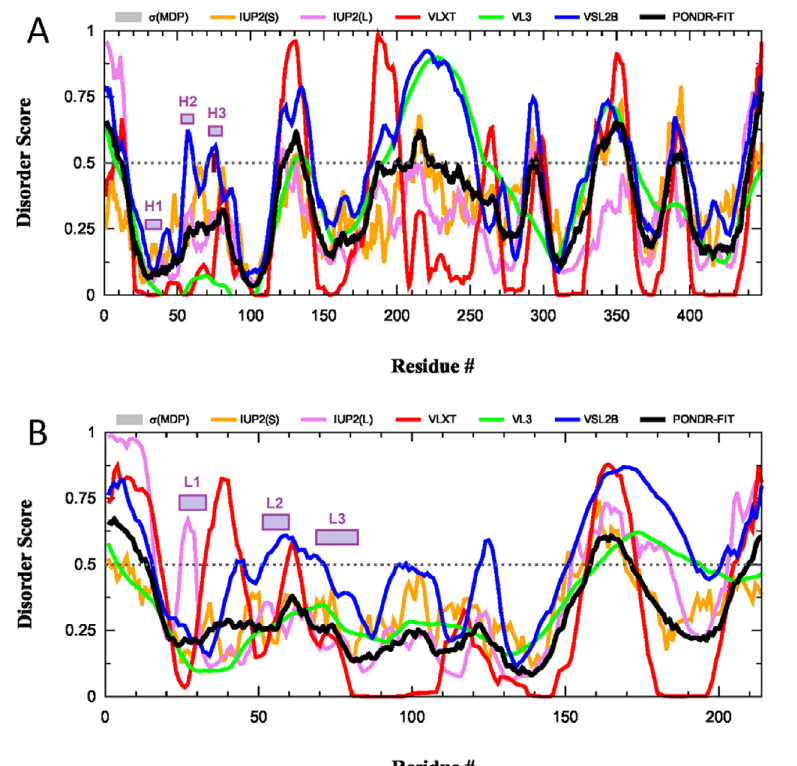
Figure 5. Intrinsic disorder predisposition of H and L chains of a typical human IgG. (A) Intrinsic disorder profile of human immunoglobulin gamma-1 H chain (UniProt ID: P0DOX5); (B) intrinsic disorder profile of human immunoglobulin gamma-1 L chain (UniProt ID: P0DOX7). Positions of CDRs in each chain are shown by colored